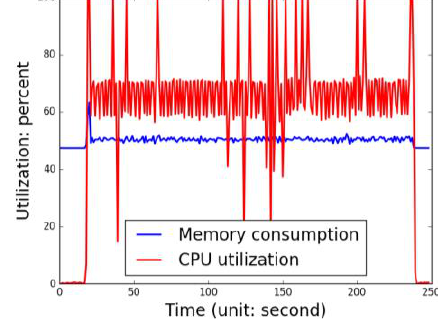
Figure 12 Result of robustness experiment. The x-axis is the elapsed time and y-axis is the percentage of usage of computer memory and CPU. The red line denotes the consumption of